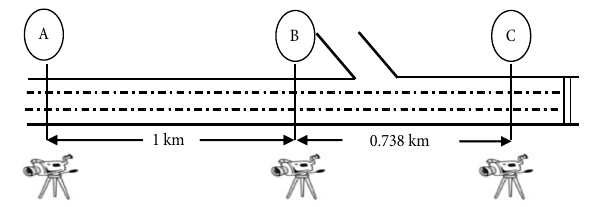
Fig. 3. Schematic sketch of study stretch showing the study